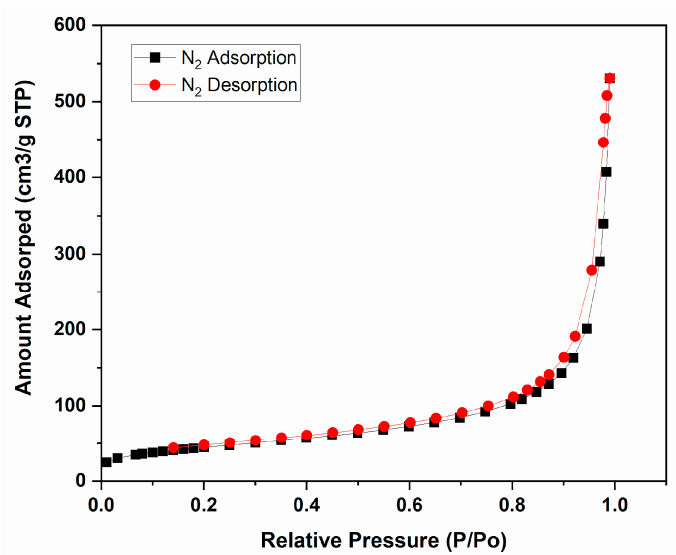
Figure 6. N 2 adsorption–desorption isotherms of Bipy-PAN measured at 77